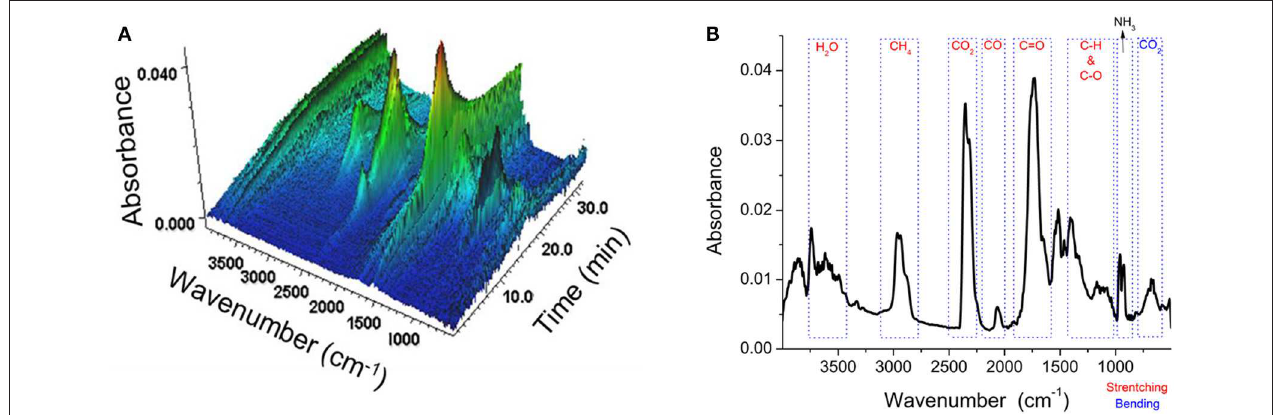
FIGURE 3 | TGA-FTIR analysis of chicken feathers with (A) maximal evolved volatiles and (B) Gram-Schmidt spectra.